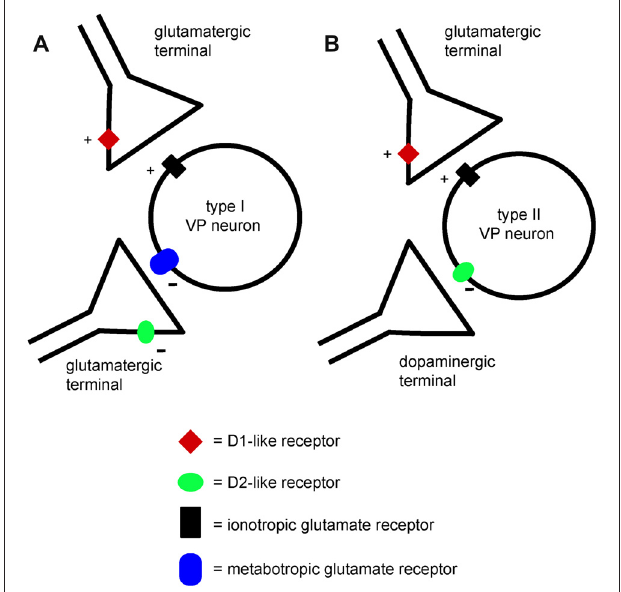
FIGURE 11 | A minimal model explaining the differential effects of D1-like and D2-like receptor activation on type I and type II VP neurons in the VP. (A) Presynaptic D1-like receptors facilitate glutamate release and excite type I VP neurons through increased activation of ionotropic glutamate receptors. Another glutamatergic input to type I neurons activates inhibitory metabotropic glutamate receptors. Presynaptic D2-like receptors have an inhibitory effect on this glutamate input, reducing glutamate release and disinhibiting type I neurons. Thus, both D1-like and D2-like receptor have excitatory influences on type I neurons. (B) Presynaptic D1-like receptors facilitate glutamate release and excite type II VP neurons by increasing activation of ionotropic glutamate receptors. Postsynaptic D2-like receptors have direct inhibitory effects on type II VP neurons. The net influence of dopamine on type II neurons results from the balance of excitatory D1-like receptor effects and inhibitory D2-like receptor effects.